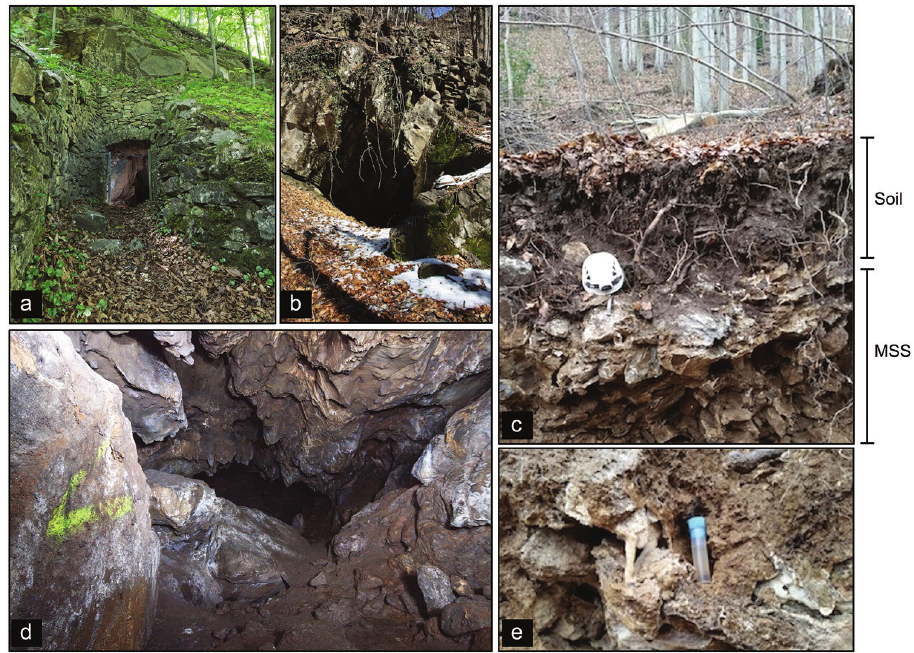
Figure 1. a Main entrance of the Borna di Pugnetto (photo credit: Alberto Chiarle and Mauro Paschetta, 2014) b Main entrance of the Creusa d’le Tampe (photo credit: Elena Piano 2013) c exposed soil/MSS profile in a fresh-cut along a slope in the vicinity of the Borna di Pugnetto (photo credit: Jacopo Orlandini, 2014) d the typical cave geo-morphology within the Borna di Pugnetto (photo credit: Alberto Chiarle and Mauro Paschetta, 2014) e detail of the MSS geo-morphological structure (photo credit: Jacopo Orlandini,